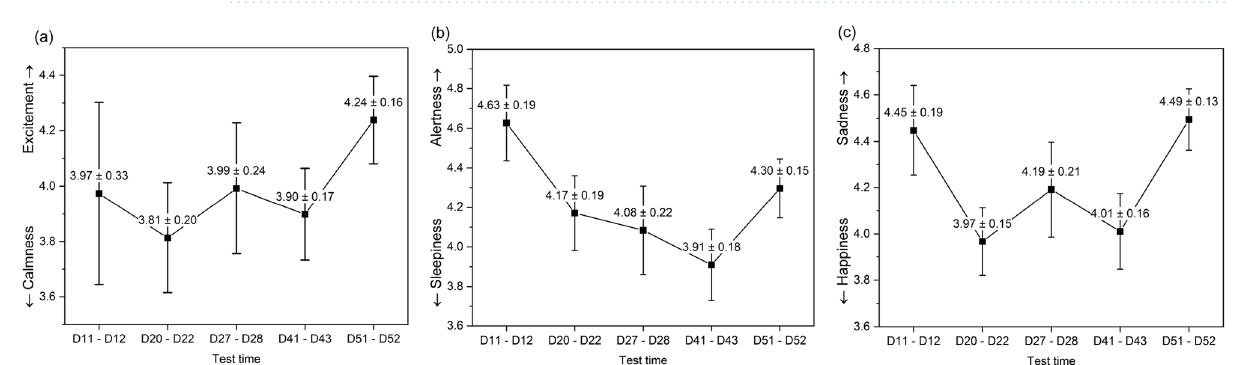
Figure 3. Subjects’ mood values in five assessments during the experiment (mean ± SEM), including ( a ) calmness/excitement, ( b ) sleepiness/alertness, and ( c ) happiness/sadness. The first assessment was before the shift work. The last assessment was after the shift work. The other three assessments were during the consecutive shift work. (The figure was generated by Origin 2018, URL: https:// www. origi nlab.